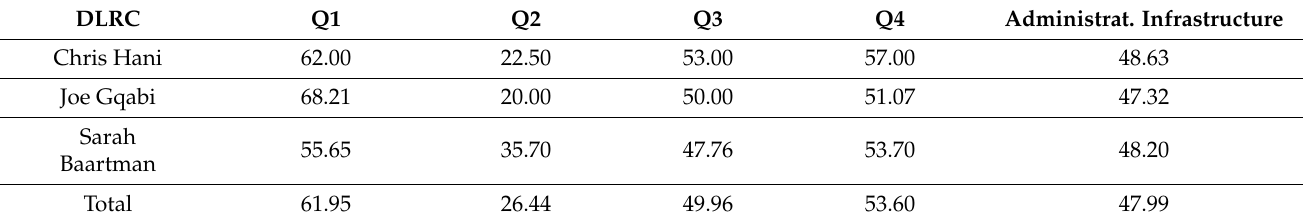
Table 3. Administrative infrastructure (average standardized assessment score in